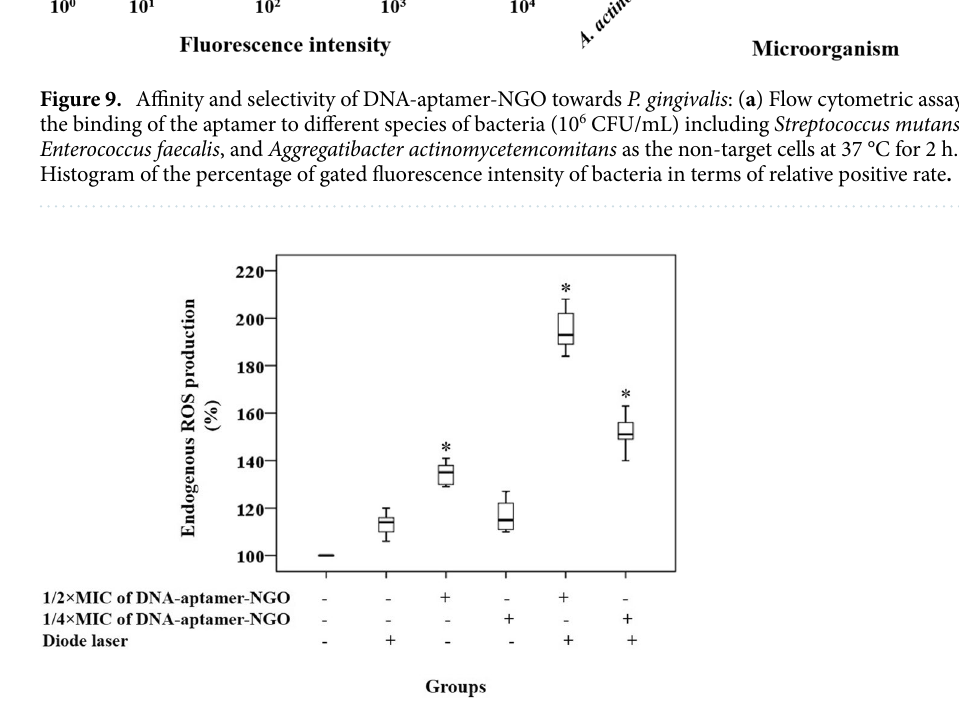
Figure 10. Generation of endogenous ROS. Generated ROS was quantified by fluorescence spectroscopy using 2 ′ ,7 ′ -dichlorofluorescein diacetate (H 2 DCF-DA) after treatment of P. gingivalis (10 8 CFU/mL) exposed to DCFH-DA (10 μM) with 1/2 × and 1/4 × MIC of DNA-aptamer-NGO, aPDT (DNA-aptamer-NGO at 1/2 × and 1/4 × MIC plus diode laser), and diode laser. The control group (only bacterial cells) was left untreated. Significant differences according to the control, * P <